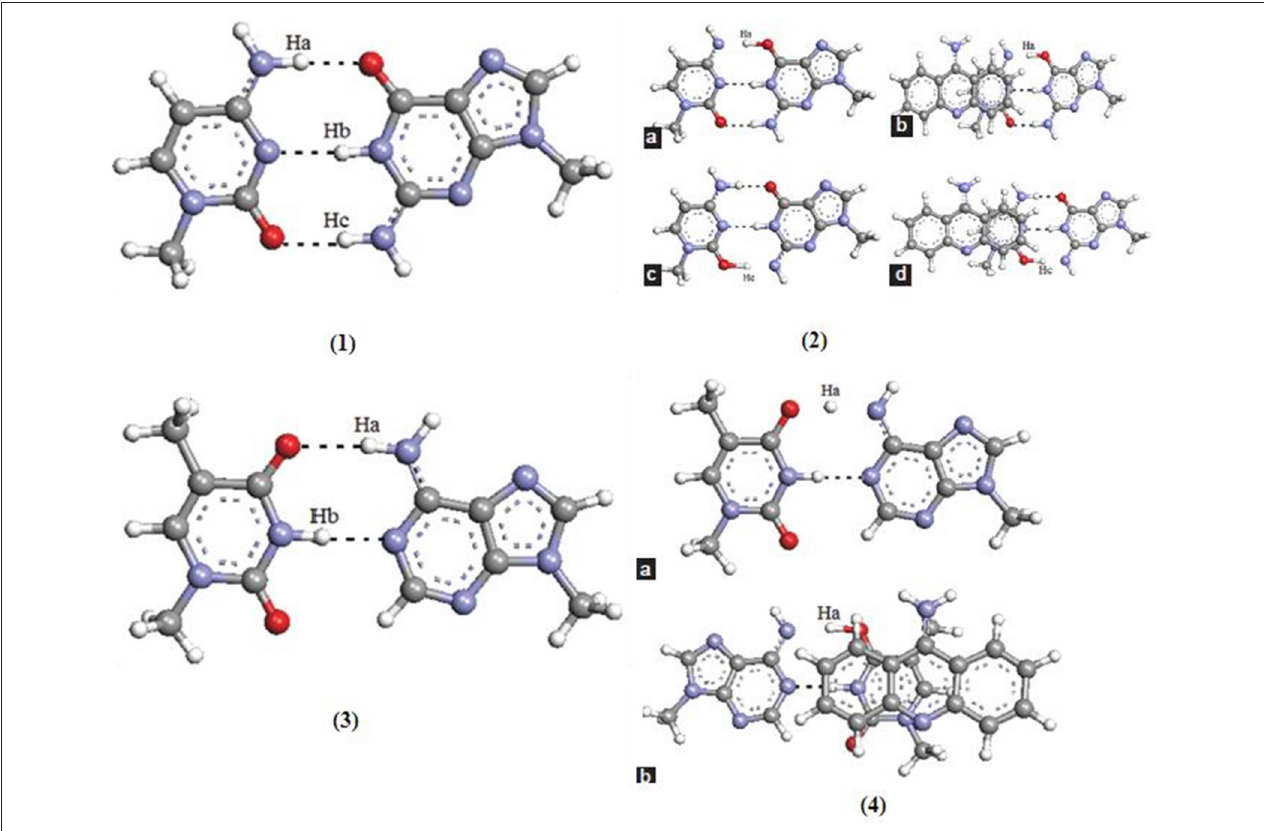
FIGURE 9 | Optimized structure of (1) guanine–cytosine base pair; transition states of (2a) unstacked GC base pair for proton (Ha) transfer type PT1, (2b) stacked GC base pair for proton (Ha) transfer type PT1, (2c) unstacked GC base pair for proton (Hc) transfer type PT2, and (2d) stacked GC base pair for proton (Hc) transfer type PT2; (3) optimized structure of (3) adenine–thymine base pair; transition states of (4a) unstacked GC base pair for proton (Ha) transfer type PT1, (4b) stacked GC base pair for proton (Ha) transfer type PT1 (Adapted from Bezbaruah and Medhi,